Question: Sum up the contents of this chart in one sentence.
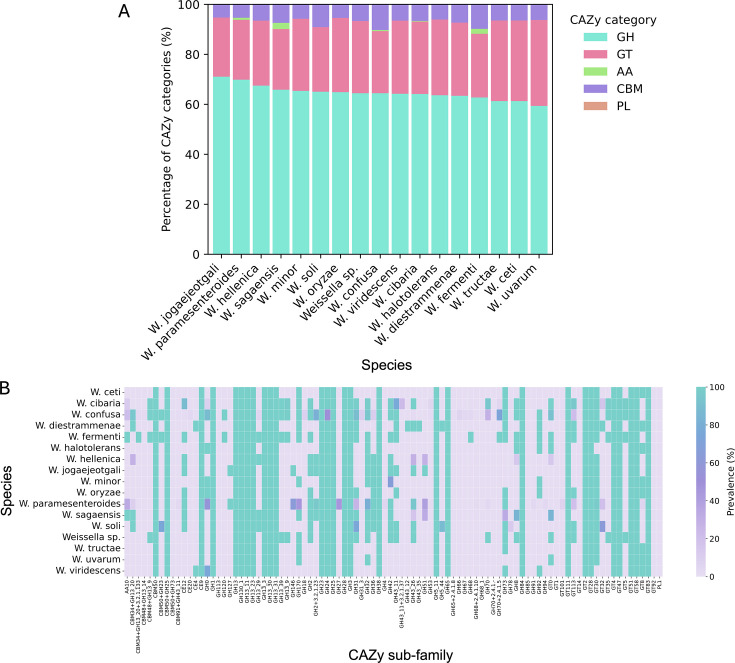
Answer: Relative distribution (%) of CAZy categories across Weissella species. ( A ) For each species, bars represent the proportional contribution (%) of GH, GT, AA, CBM, and PL, calculated from the mean number of CAZymes per genome, and colors indicate CAZy categories. ( B ) Heatmap showing the prevalence (%) of CAZy sub-families across Weissella species. Color intensity indicates the prevalence of each sub-family within a species.